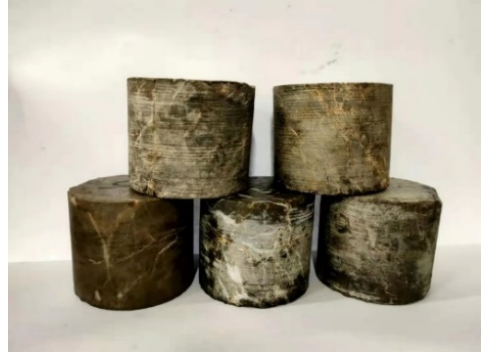
Figure 4. Limestone specimen.